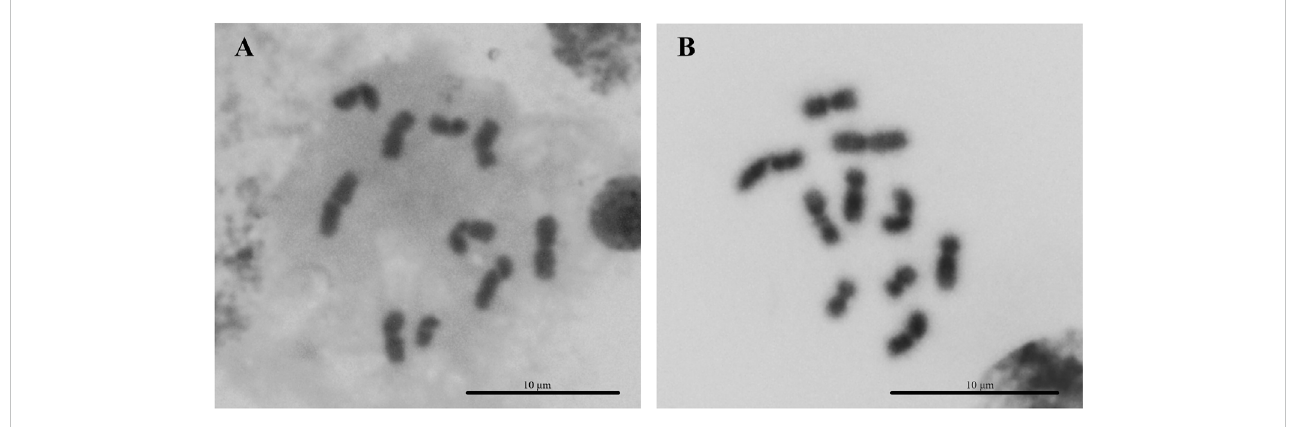
FIGURE 2 Karyotypes of two strains of Diglyphus wani . (A) Thelytokous female (2 n = 10) (B) arrhenotokous female (2 n = 10).